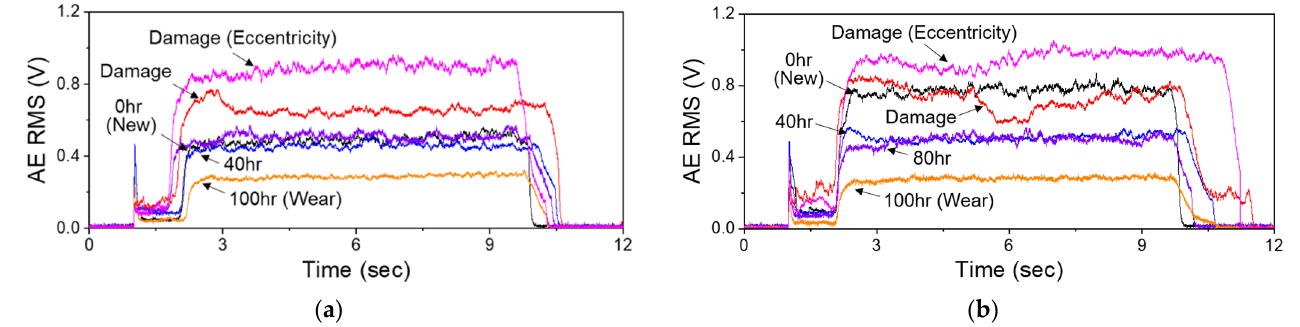
Figure 9. A comparison of the AE RMS values of new, worn, and damaged nozzles: ( a ) AE RMS values at a waterjet pressure of 300 MPa and an abrasive feed rate of 350 g/min, and ( b ) AE RMS values at a waterjet pressure of 350 MPa and an abrasive feed rate of 450 g/min.